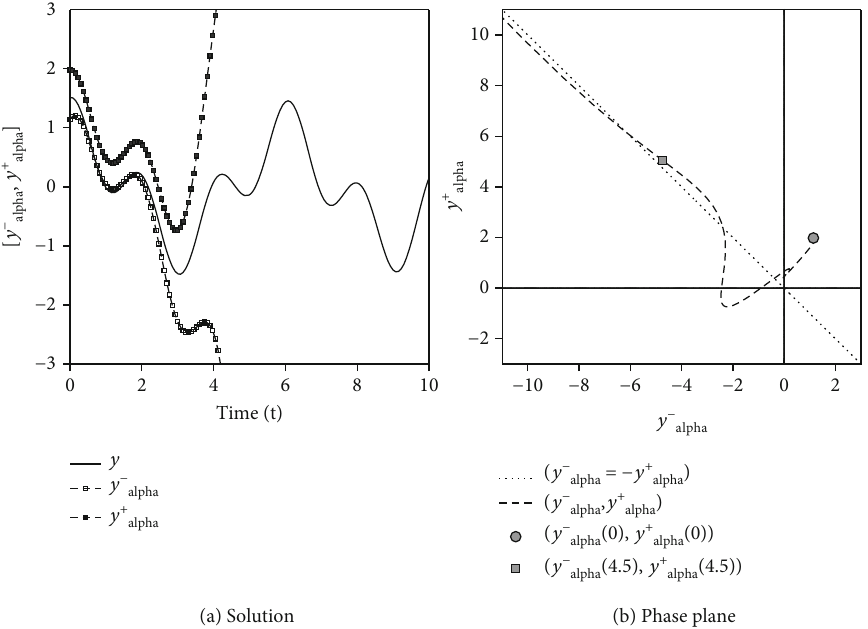
Figure 2: Solutions of Equation (24), the α − cut deterministic system which is obtained from applying the gHd concept. It is performed by using the extended RK method with the parameters which are in Equation (27) and the initial values which are in Equation (28). For (a) and (b), similar information as in Figures 1(a) and 1(b) are applied, except in (b), the black-marked square states coordinate point ð y − α ð 4 : 5 Þ , y + α ð 4 : 5 ÞÞ